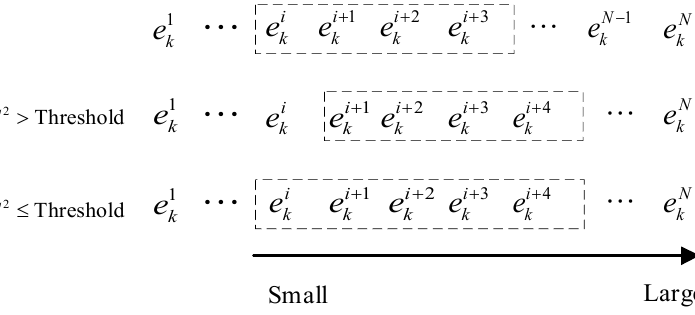
Figure 5. Windowing process for fault detection based on Set I.